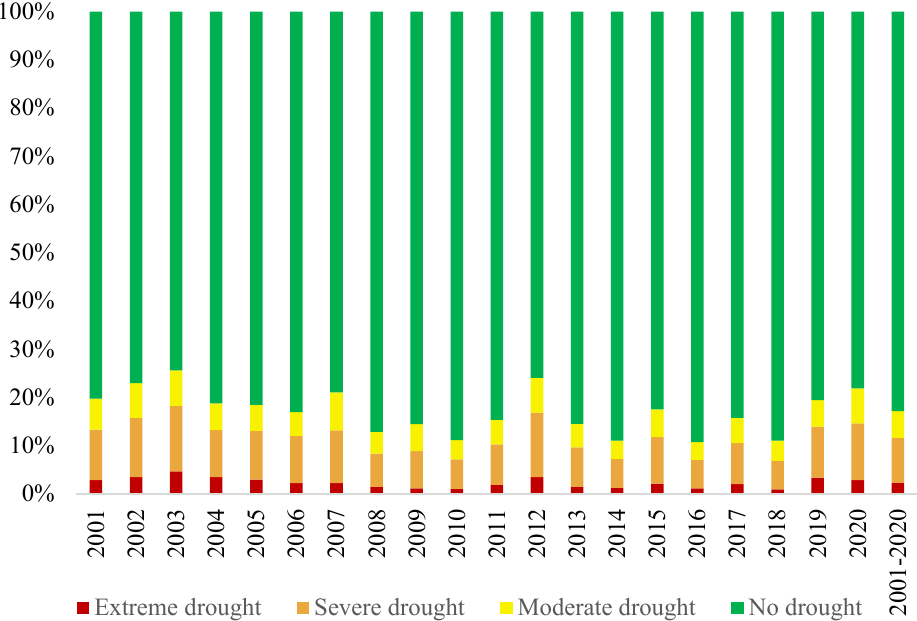
Figure 2. Relative frequency (%) of NDDI main drought classes between 2001 and 2020.